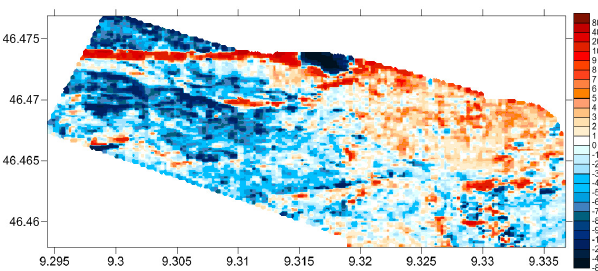
Figure 6. HR-LR differences in the valley of S.Giacomo. The presence of systematic patterns is clear: biases with opposite signs that are present on the valley left and right slopes are hardly observable in the B/W figure.